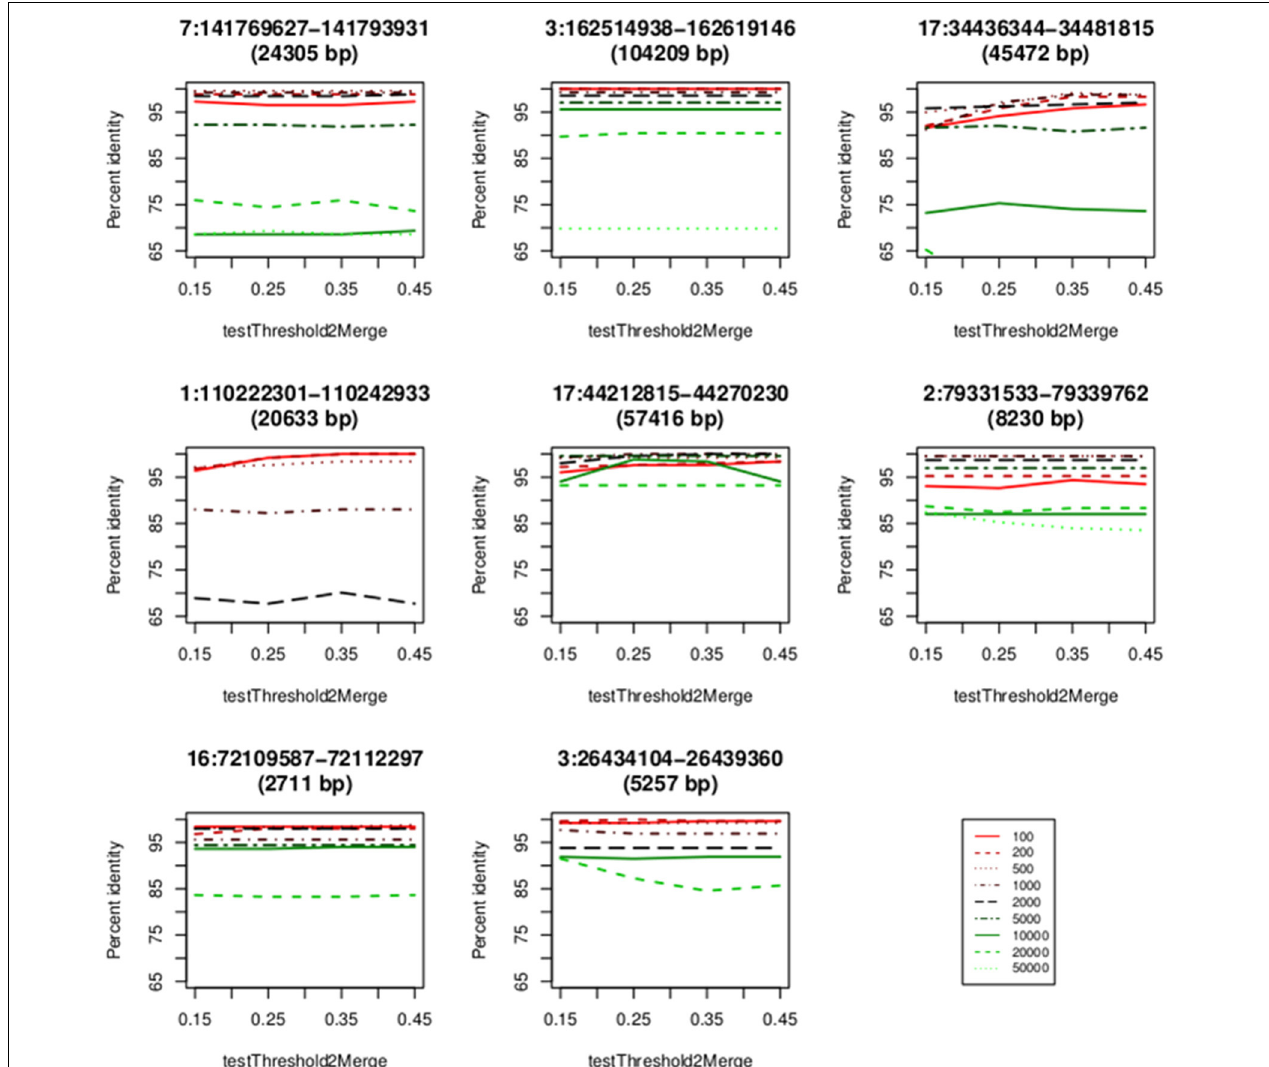
FIGURE 5 | Concordance between the CNVrd2 and microarray based results. The x-axis contains the values of testThreshold2Merge (0.15, 0.25, 0.35, 0.45). The y-axis is the percentage of identical results.